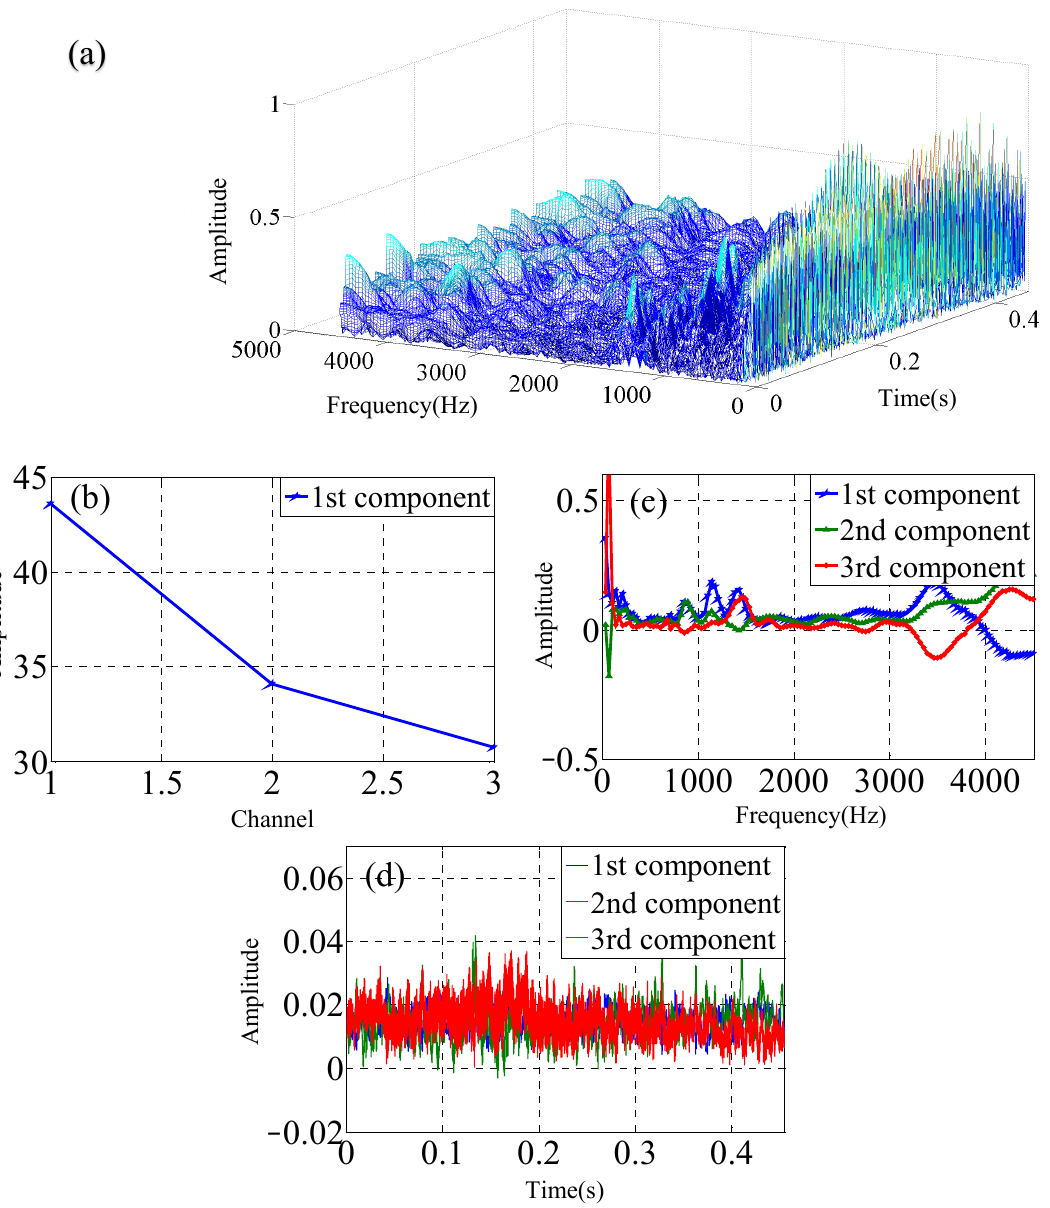
Figure 4. PARAFAC for one data from one channel of single sensor under F1 condition, ( a ) CWT of single-channel data, ( b ) mode 1, ( c ) mode 2, ( d ) mode 3.